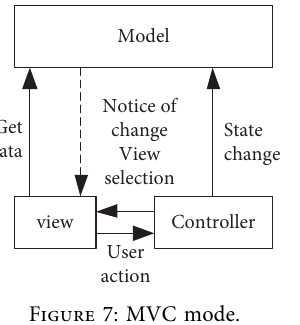
Figure 7: MVC mode.